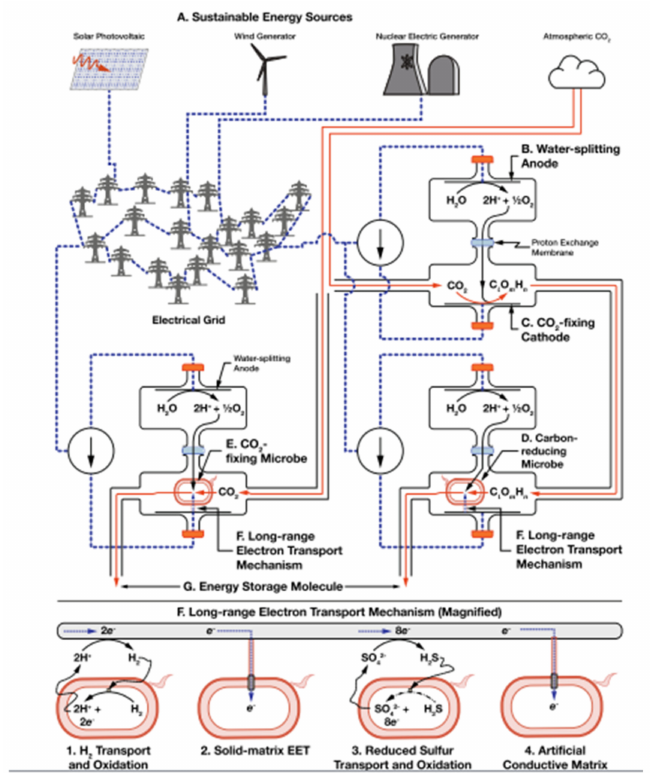
Figure 8. Fixation rewiring system consists of: ( A ) sustainable energy capture, ( B ) water splitting, ( C ) electrochemical CO 2 fixation, ( D ) additional biological reduction ( E ) or biological CO 2 fixation, ( F ) long-range electron transport to biological metabolism, and ( G ) synthesis of energy storage molecules [26]. No changes were made to the original